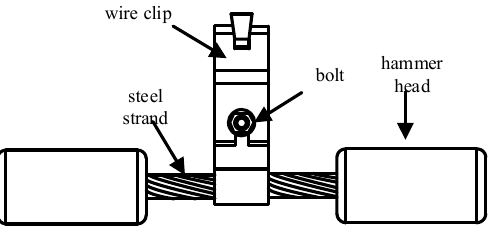
Figure 2. Schematic drawing of the Stockbridge damper.